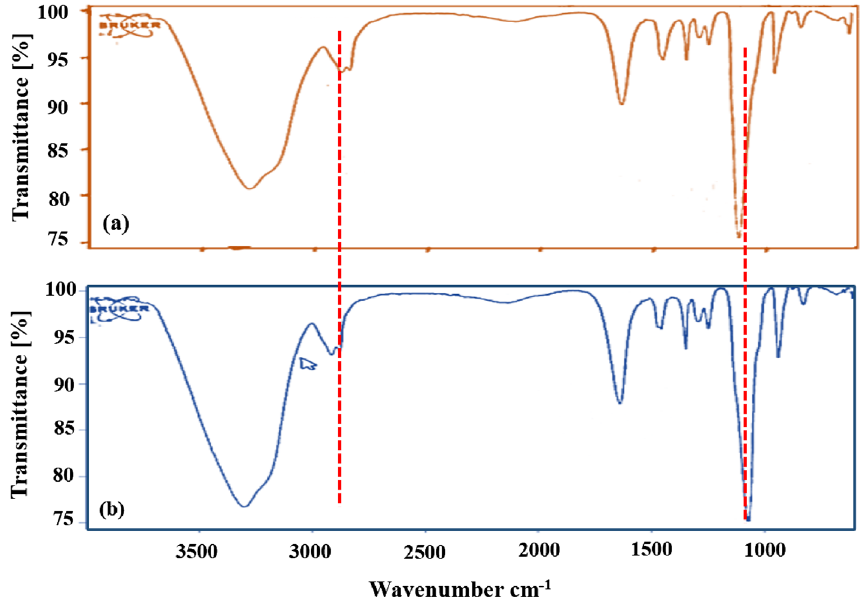
Figure 10. IR spectra of PEG and